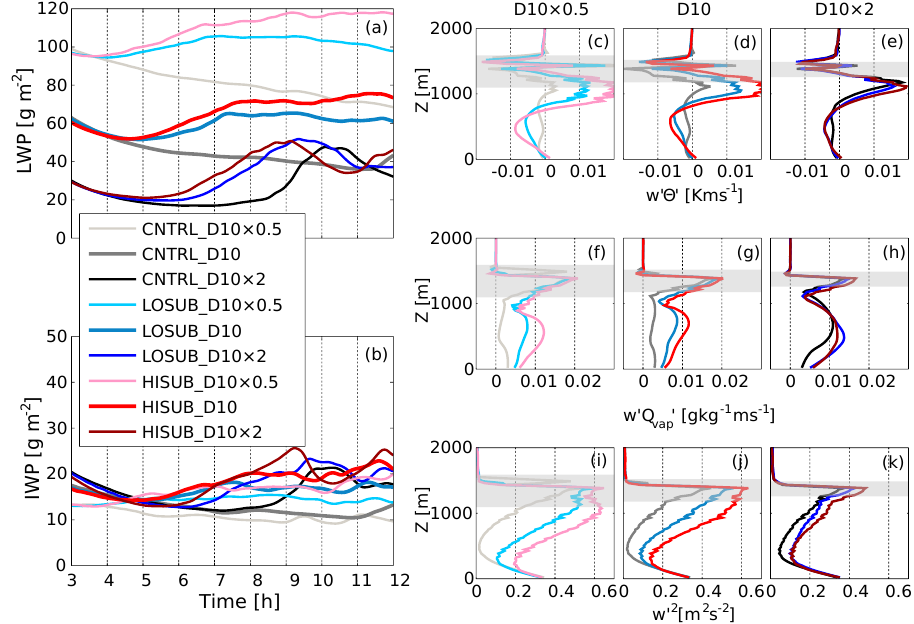
Figure 6. As Fig. 4 but with changing ice number